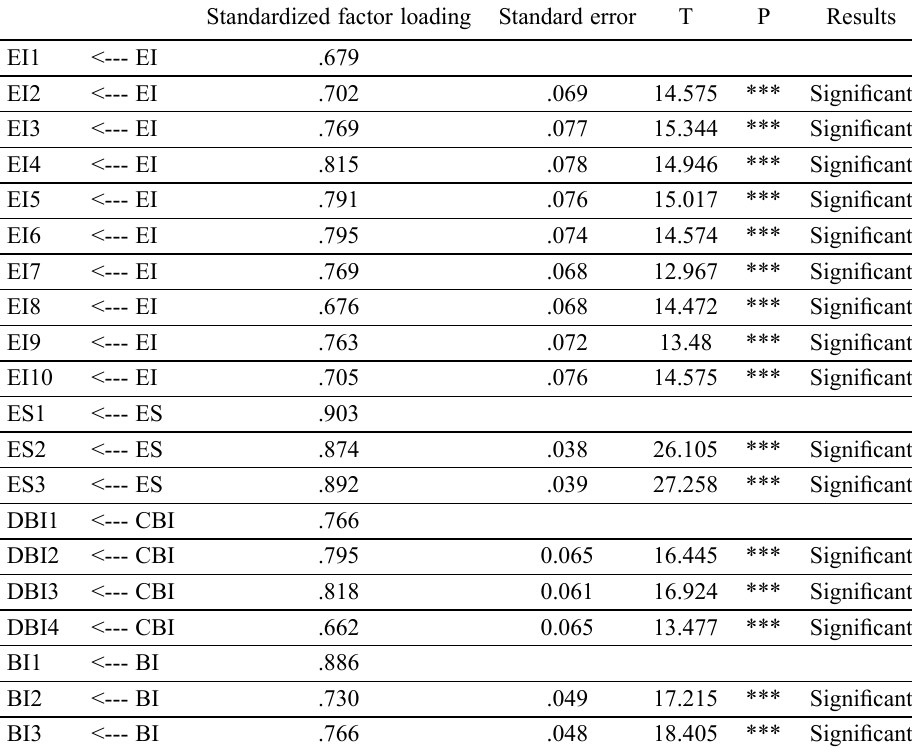
Table 2. Measurement model factor loading